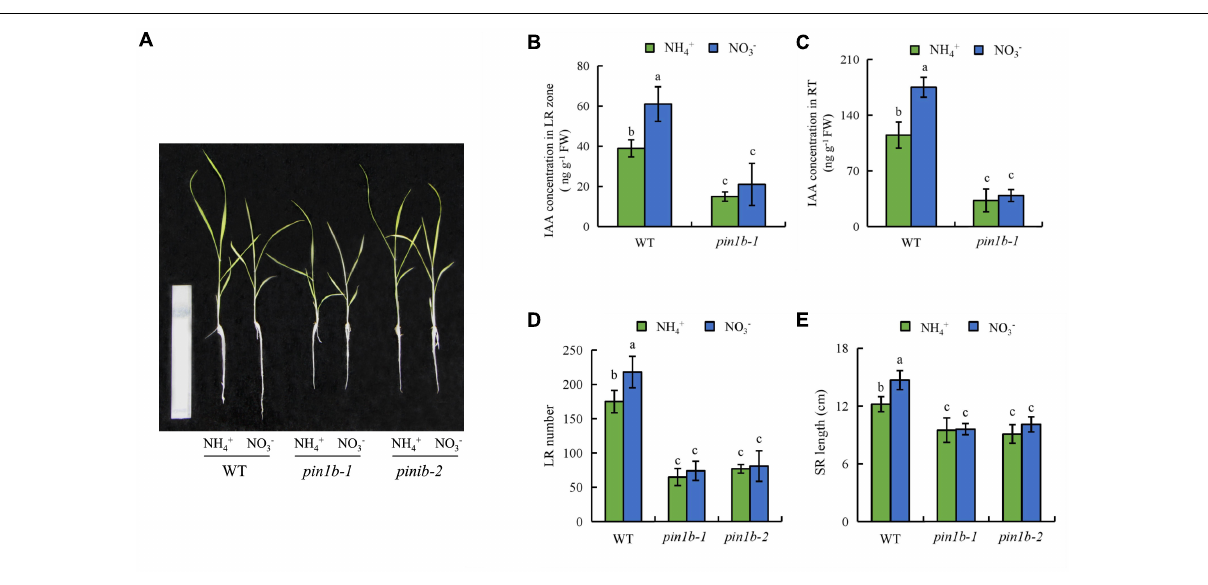
FIGURE 8 | Root morphology and IAA concentration in pin1b mutants and wild-type (DJ) the rice seedlings. Seedlings were grown in hydroponic medium containing NH 4 + and NO 3 − for 14 days. (A) , The morphology of the rice plants; (B,C) , IAA concentration in the lateral root region (B) and root tip (C) ; (D) , Lateral root (LR) number; (E) , Seminal root (SR) length. Bar = 1 mm. Data are means ± SE and bars with different letters indicate significant difference at P < 0.05 tested with